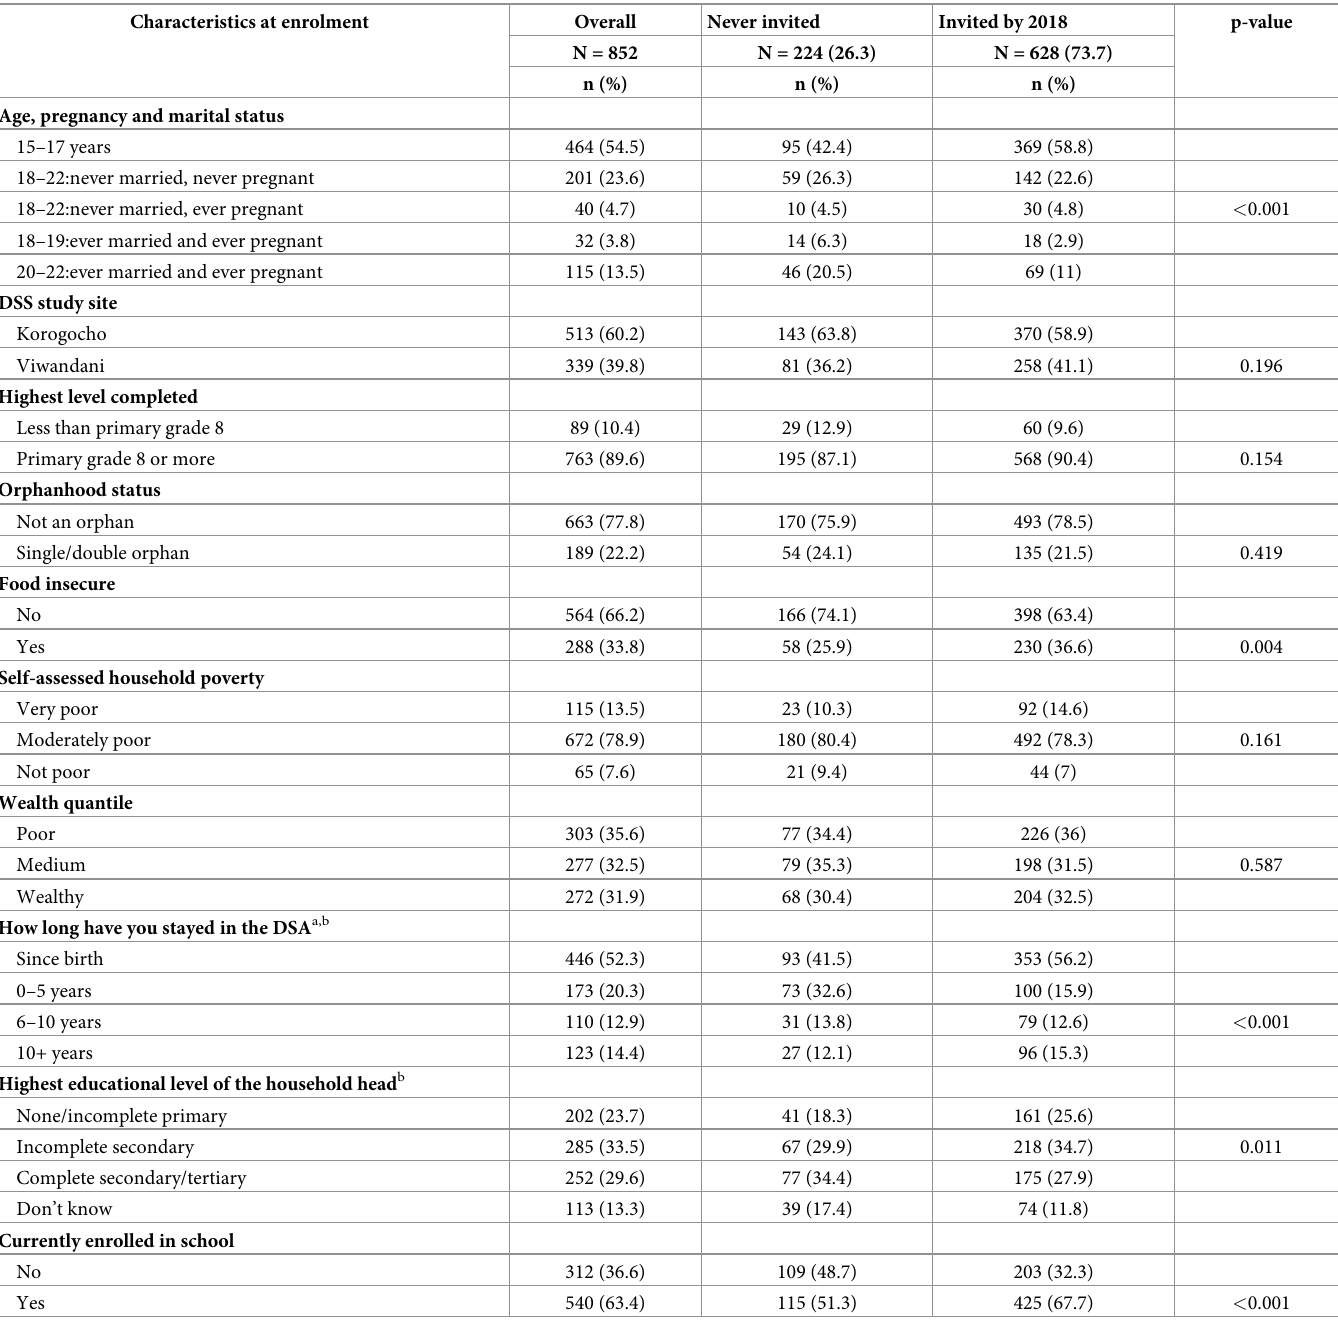
Table 2. Enrolment profile (characteristics at cohort enrolment) among AGYW aged 15 − 22 years and followed up in 2019, by invitation to participate in DREAMS. Characteristics at